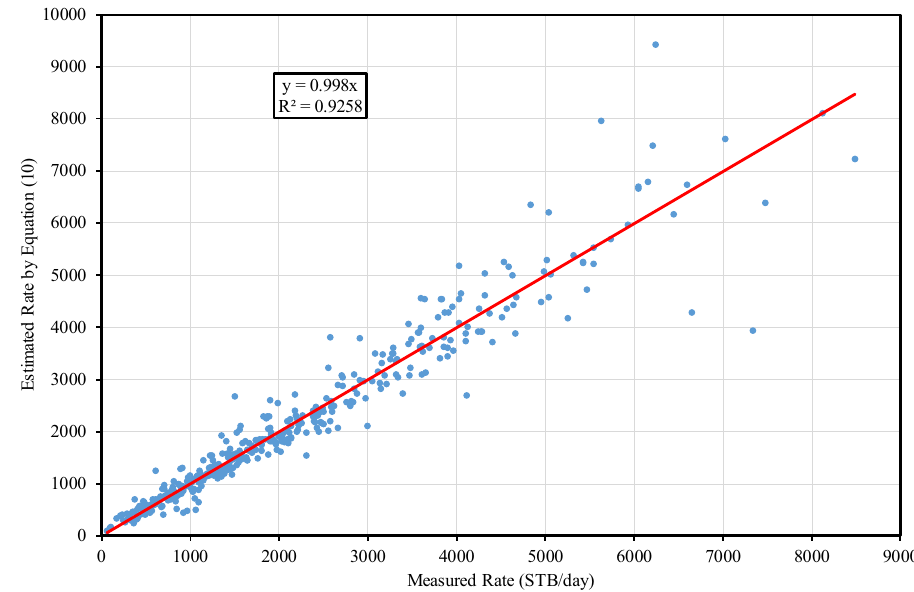
Fig. 3 Comparison of estimated oil well rate, Eq. 10, with meas- ured rate